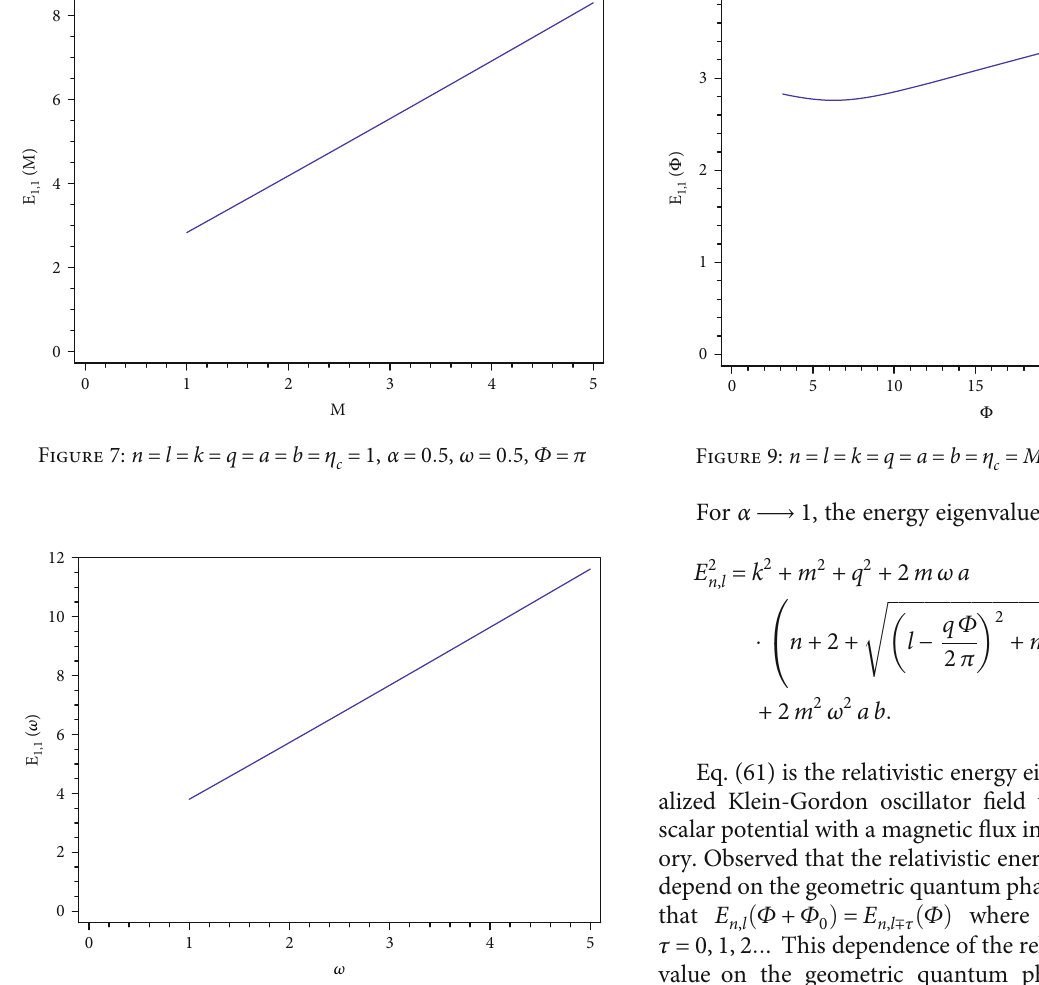
= M = 1 , α = 0 : 5 , Φ = π c